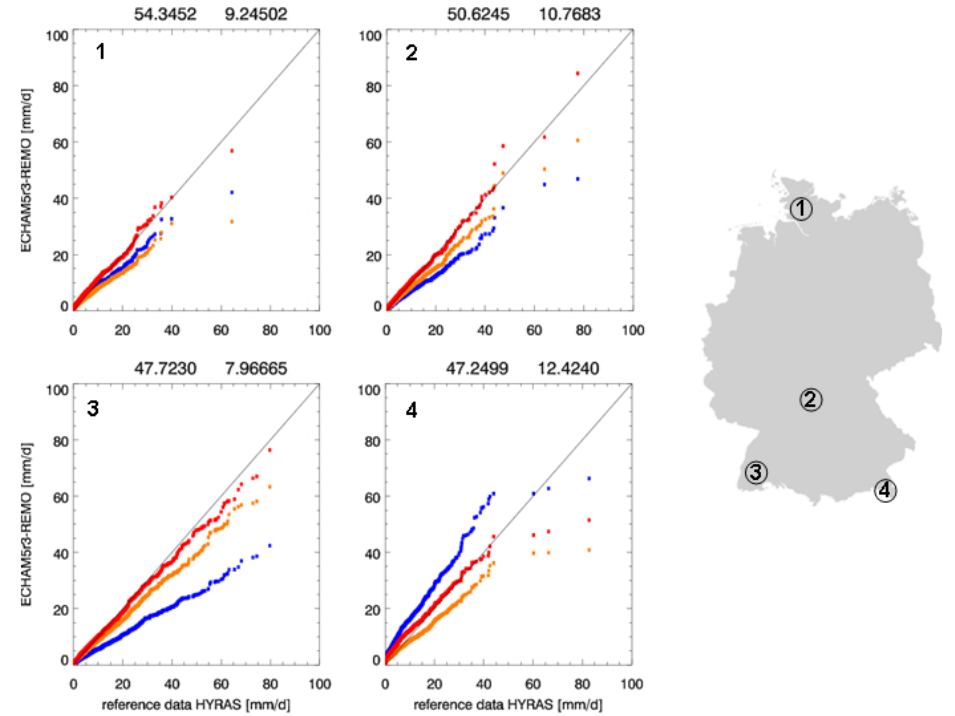
Figure 1. qq-Plots for di ff erent bias-correction methods for precipitation for the A1B-ECHAM5r3-REMO5.7 run. Uncorrected (blue), linear- scaling method (orange) and quantile mapping approach (red) in comparison with HYRAS-PRE for 1961–1990 on four di ff erent regions in the KLIWAS area. (1) Coastal regions (north sea, Schleswig-Holstein west coast), (2) hilly landscape, dominated by croplands (Thuringian Forest), (3) mid-latitude mountain regions (Black Forest) and (4) alpine regions (Berchtesgaden National Park).